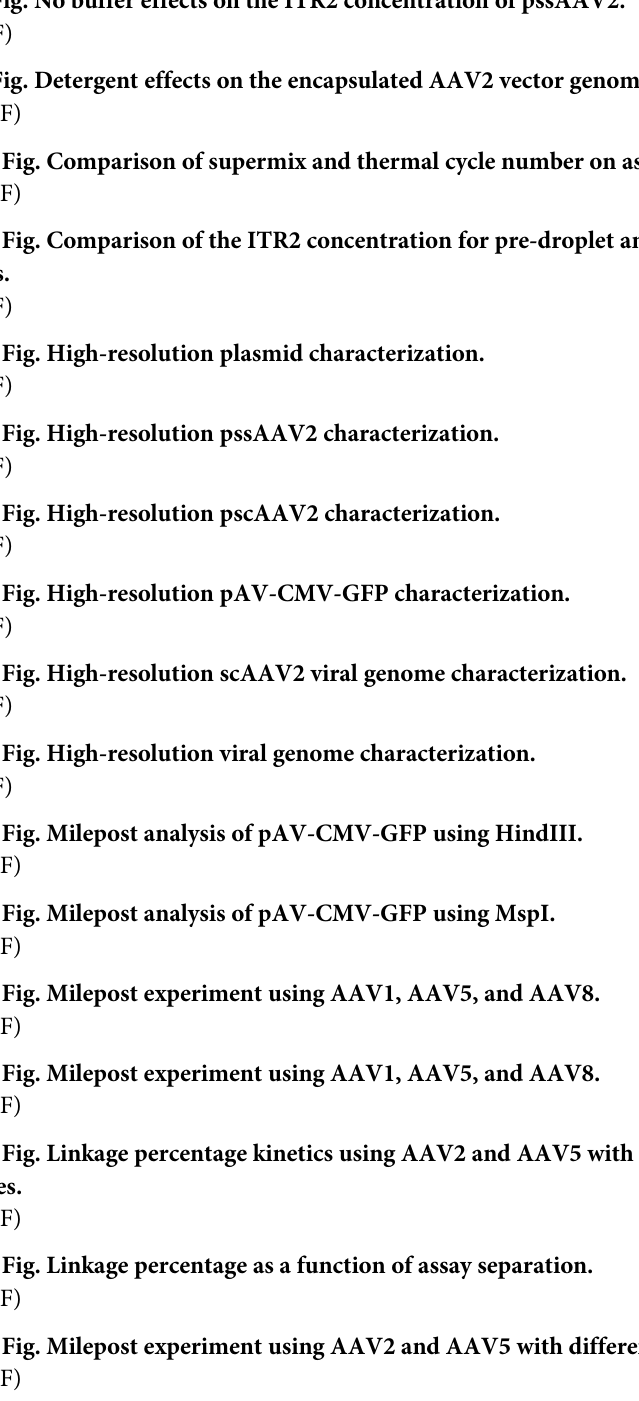
S7 Fig. DNase I activity in the presence of 0.1% F68. (PDF) S8 Fig. No buffer effects on the ITR2 concentration of pssAAV2. (TIF) S9 Fig. Detergent effects on the encapsulated AAV2 vector genome concentration. (PDF) S10 Fig. Comparison of supermix and thermal cycle number on assay concentration. (PDF) S11 Fig. Comparison of the ITR2 concentration for pre-droplet and in-droplet capsid lysis. (TIF) S12 Fig. High-resolution plasmid characterization. (TIF) S13 Fig. High-resolution pssAAV2 characterization. (TIF) S14 Fig. High-resolution pscAAV2 characterization. (TIF) S15 Fig. High-resolution pAV-CMV-GFP characterization. (TIF) S16 Fig. High-resolution scAAV2 viral genome characterization. (TIF) S17 Fig. High-resolution viral genome characterization. (TIF) S18 Fig. Milepost analysis of pAV-CMV-GFP using HindIII. (PDF) S19 Fig. Milepost analysis of pAV-CMV-GFP using MspI. (PDF) S20 Fig. Milepost experiment using AAV1, AAV5, and AAV8. (PDF) S21 Fig. Milepost experiment using AAV1, AAV5, and AAV8. (PDF) S22 Fig. Linkage percentage kinetics using AAV2 and AAV5 with different capsid lysis times. (PDF) S23 Fig. Linkage percentage as a function of assay separation. (PDF) S24 Fig. Milepost experiment using AAV2 and AAV5 with different capsid lysis times.